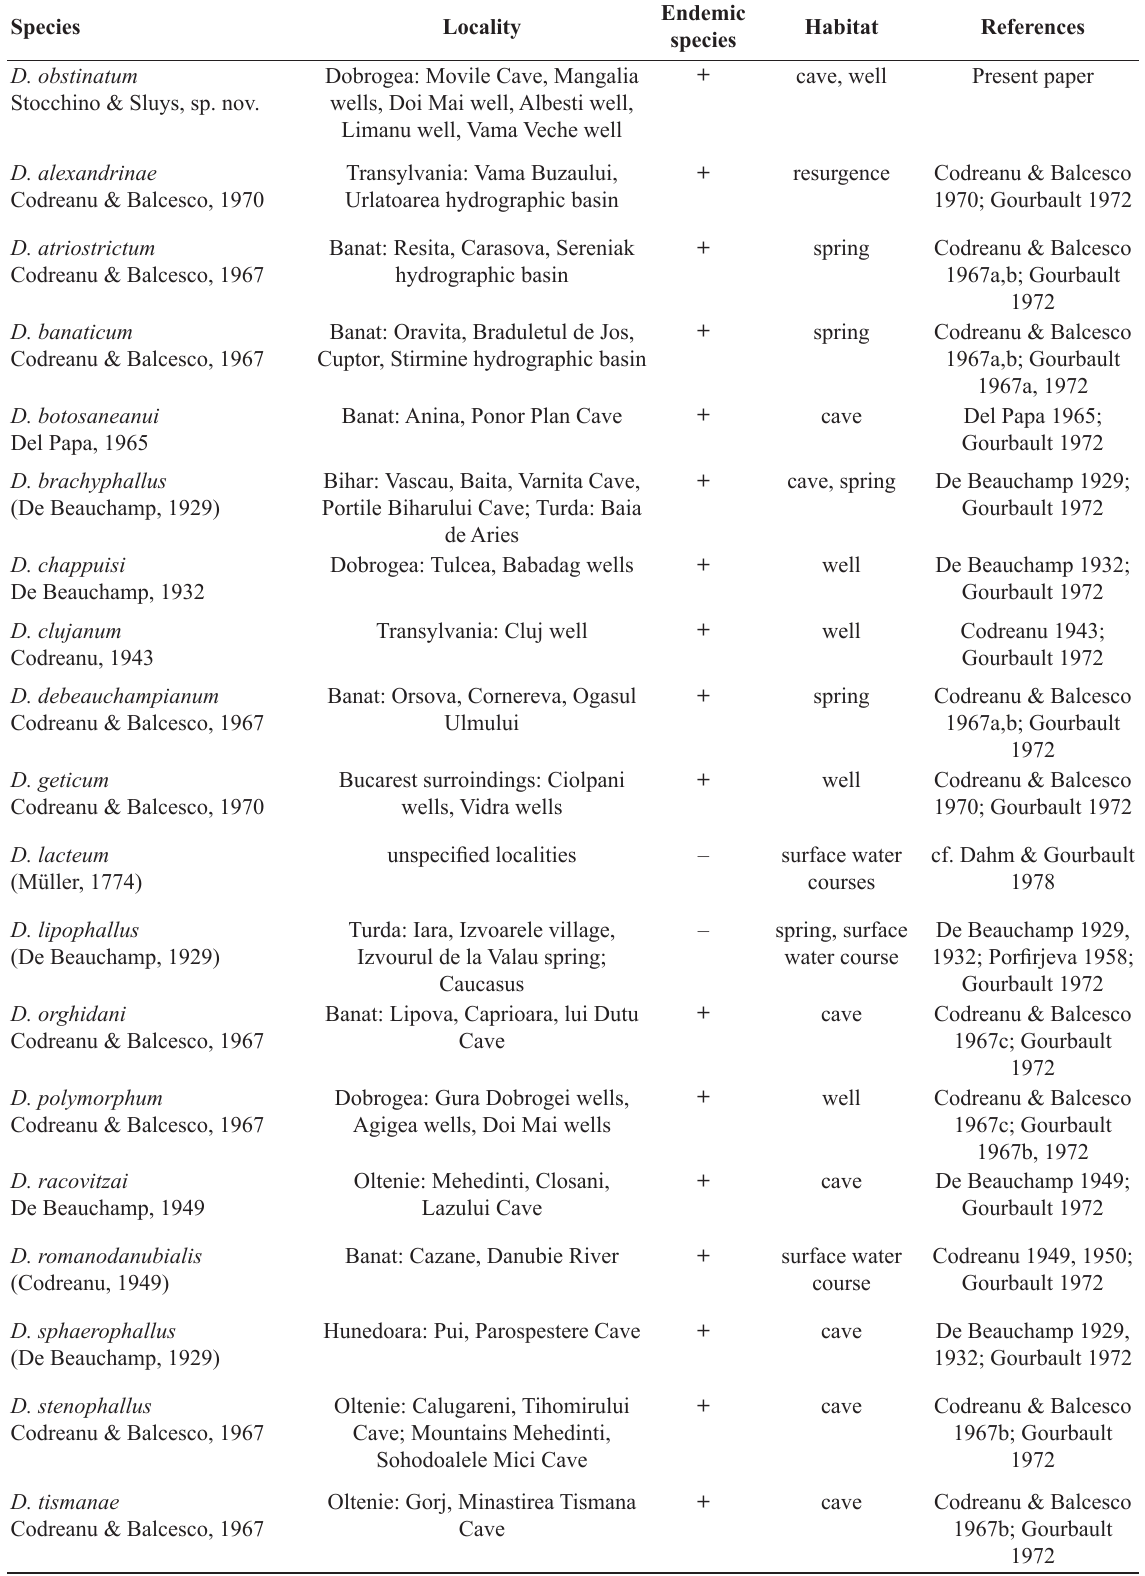
Table 2. Checklist of species of the genus Dendrocoelum Örsted, 1844